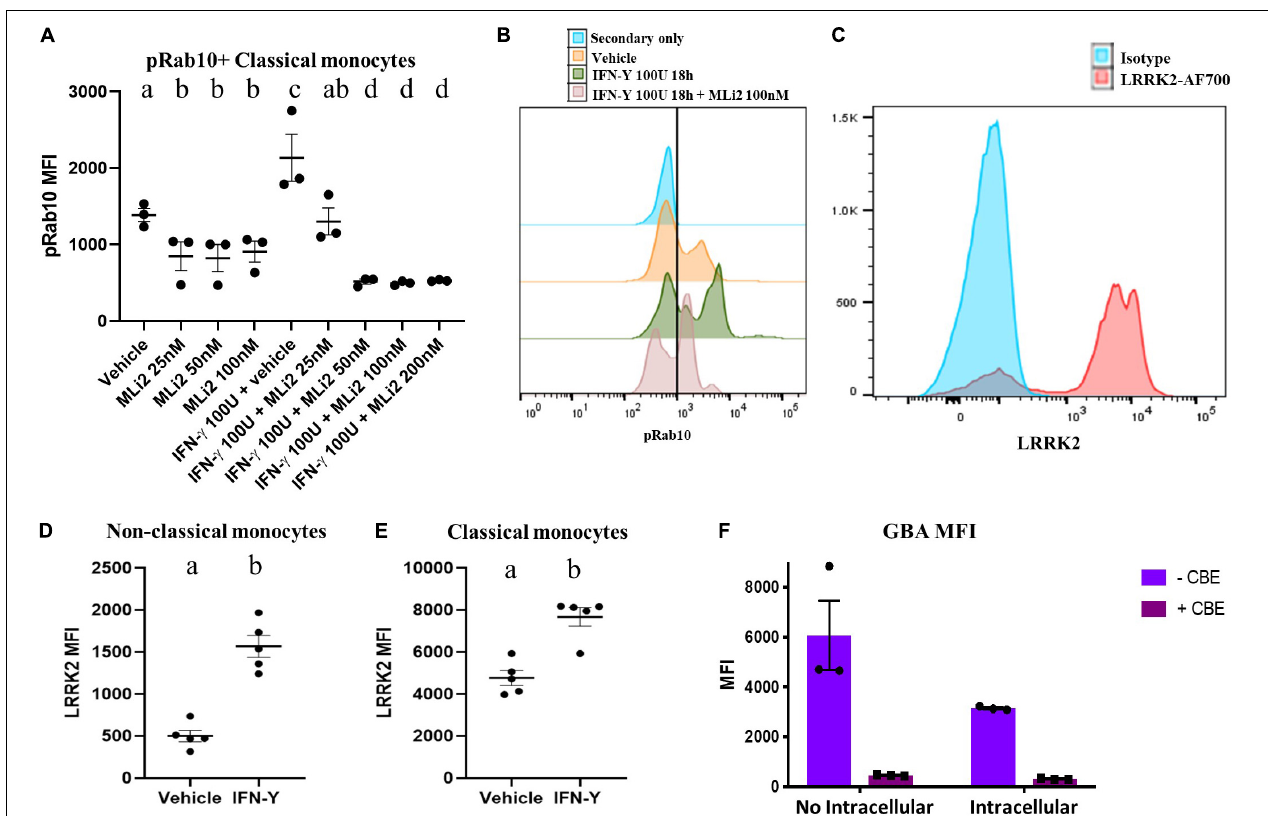
FIGURE 3 | The selected antibodies detect LRRK2 protein kinase and GCase enzymatic activity. Decreases in human pRab10 fluorescence is detectable via flow cytometry with the MJF-R21 Abcam pRab10 antibody and an AF488-conjugated secondary antibody (1:1000) with 25/50/100/200 nM of the LRRK2 protein kinase inhibitor, MLi-2, as well as increases in pRab10 fluorescence with IFN- γ treatment for 18 h, in PBMCs (A,B) . Bars represent mean ± SEM ( N = 3). One-way ANOVA, Bonferroni post-hoc , groups sharing the same letters are not significantly different ( p > 0.05). Increases in human LRRK2 protein in IFN- γ -stimulated PBMCs detectable by flow cytometry with the AF700 (Novus biologicals) antibody in both classical and non-classical monocytes (C–E) . MFI of the GCase specific fluorescent probe, PFBGLu, was measured in total monocytes in the presence or absence of CBE in either live cells with no intracellular staining, or PFA-fixed cells with intracellular permeabilization (F) . Bars represent mean ± SEM ( N = 5). Independent t -test, groups sharing the same letters are not significantly different ( p > 0.05) whilst groups displaying different letters are significantly different ( p <